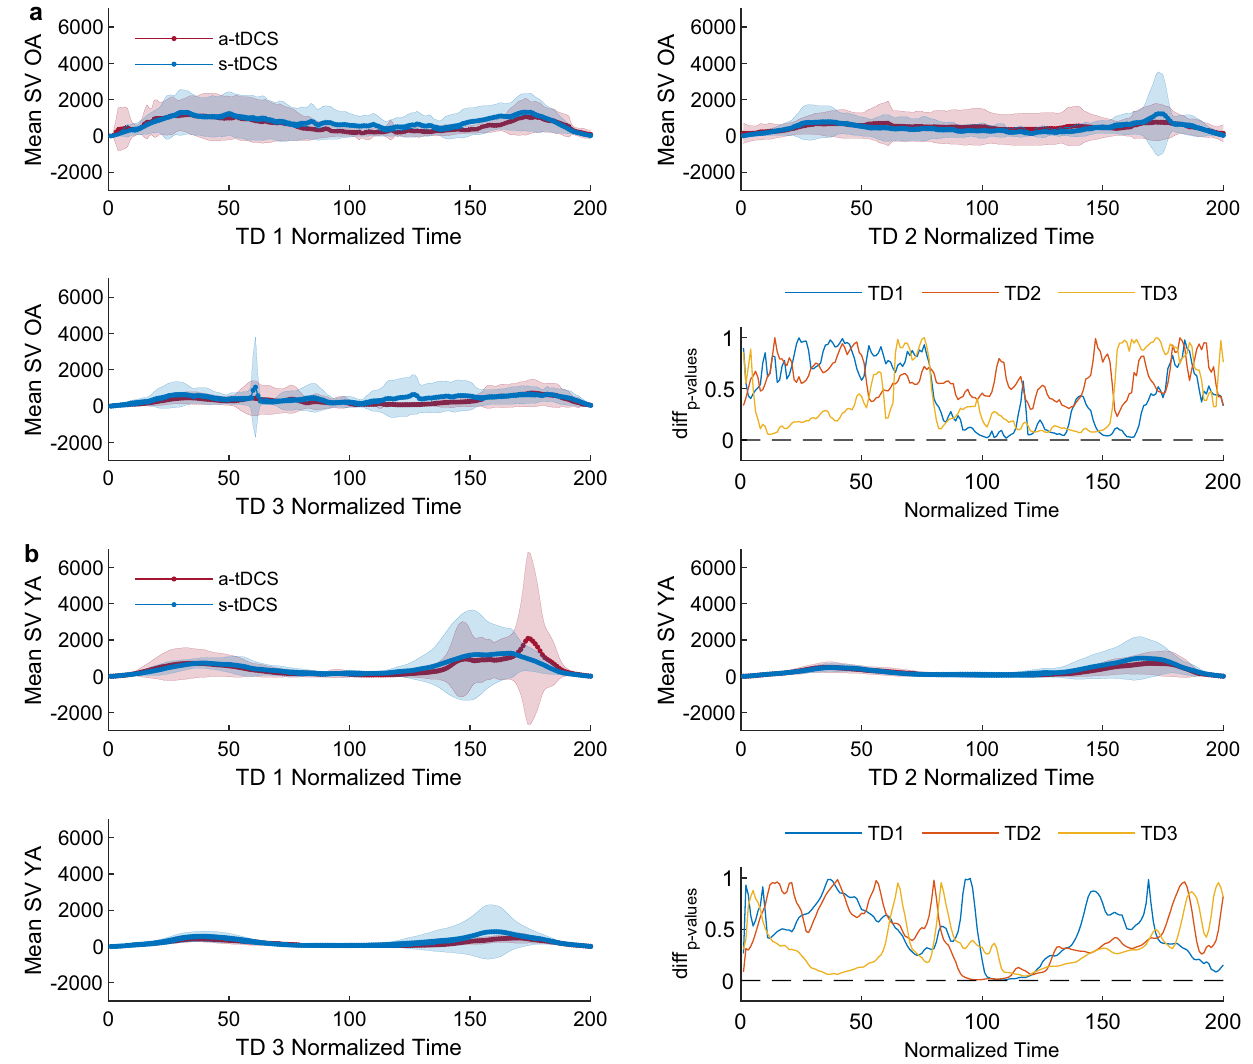
Figure 4. ( a ) OA. ( b ) YA. Plots 1–3 show spatial variability across all training days, lines represent mean values ± standard deviation. Plot 4 shows p-values for each of the 200 t-tests across all three training days investigating group differences in spatial variability of the cursors’ radial position (solid lines: blue: day 1, orange: day 2, yellow: day 3) as well as the p-value threshold corrected for multiple comparisons (dashed line, bonferoni-corrected p-value =